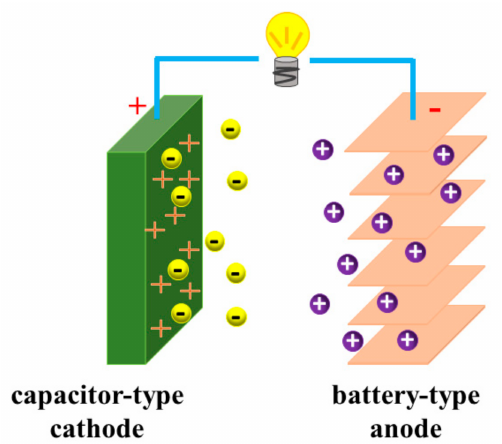
Figure 3. Schematic illustration of the configuration of hybrid